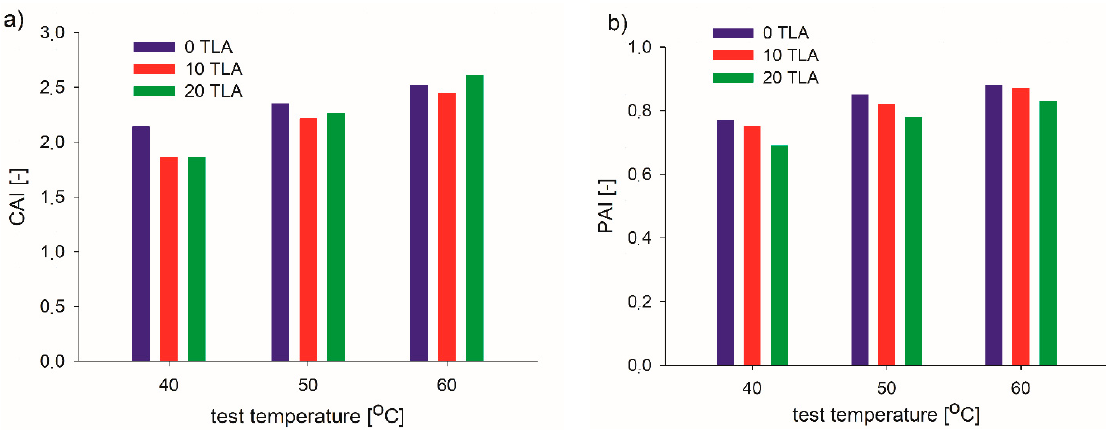
Figure 6. Rheological aging indices of the TLA-modified binders: ( a ) CAI (10 Hz frequency) and ( b ) PAI.